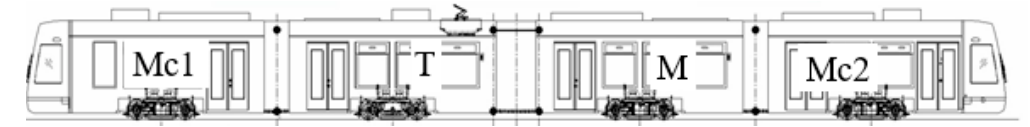
Figure 1. Overall structure of low-floor tram.